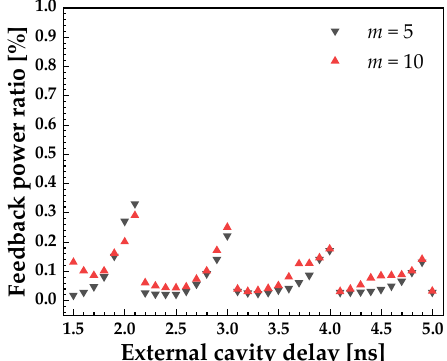
Figure 5. Hopf bifurcation point vs. time delay τ f for I = 1.1 I th .